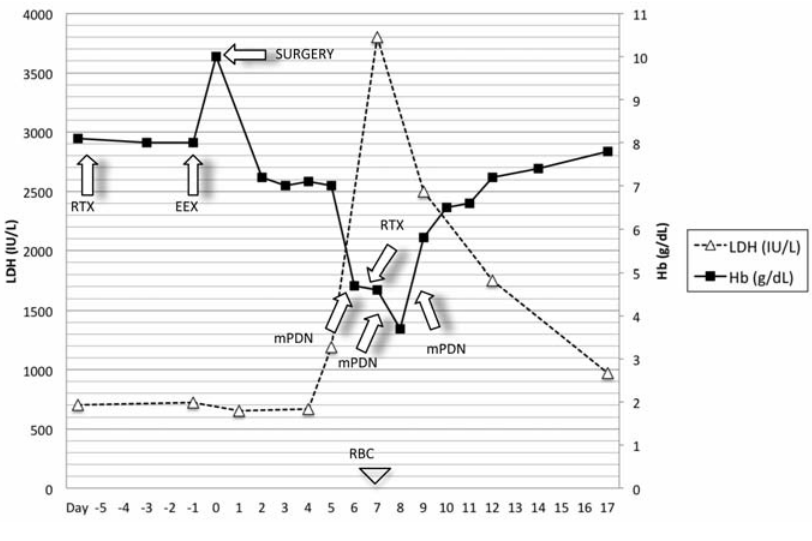
Figure 1. Trend of hemoglobin and LDH during the observation period (RBC, red blood cell transfusion; EEX, eritroexchange; RTX, rituximab; mPDN,